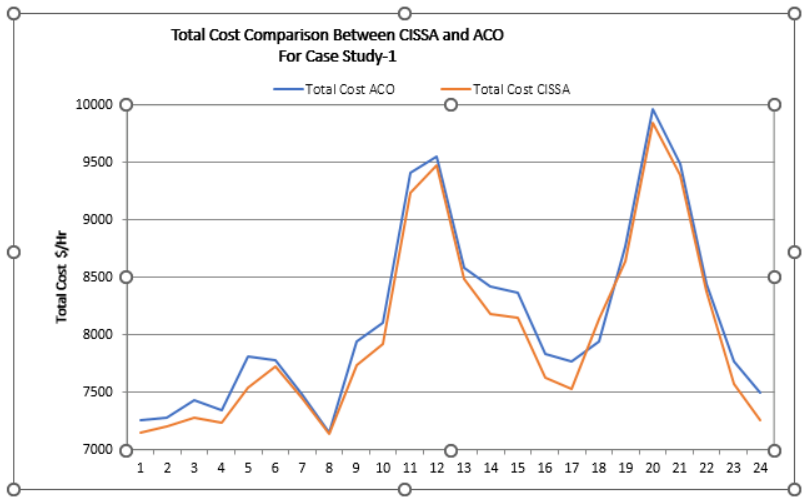
Figure 8. Total cost comparison between CISSA and ACO. Table 9. Total cost comparison between CISSA and ACO. Table 10. Total daily cost comparison — case study 1.